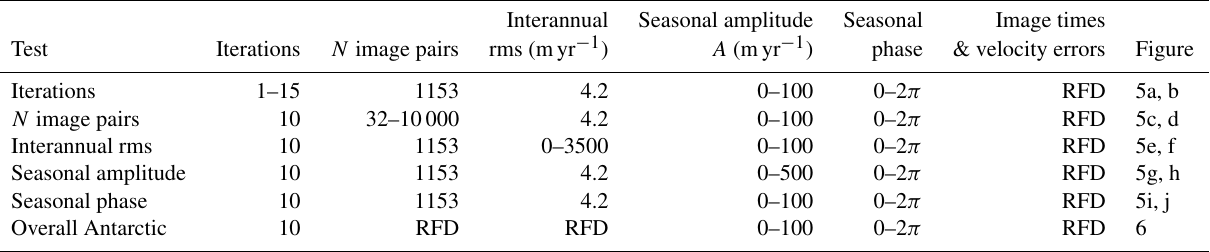
RFD indicates randomized from distribution of all 1.8 million Antarctic ITS_LIVE image pairs.